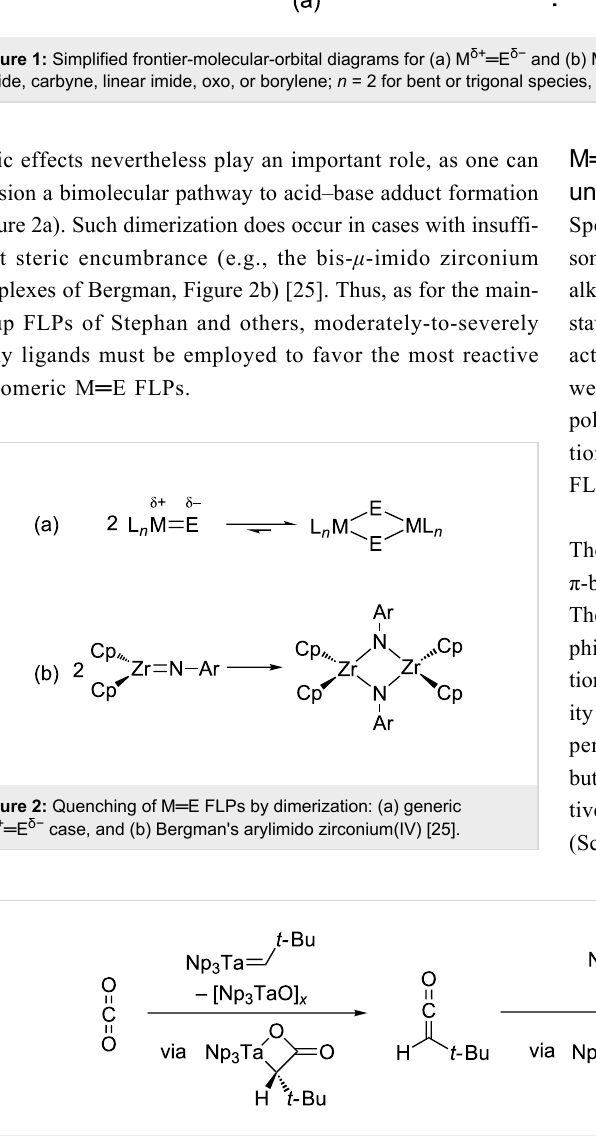
Scheme 3: Oxygen-atom extrusion from CO 2 by a Ta(V) neopentylidene [27].